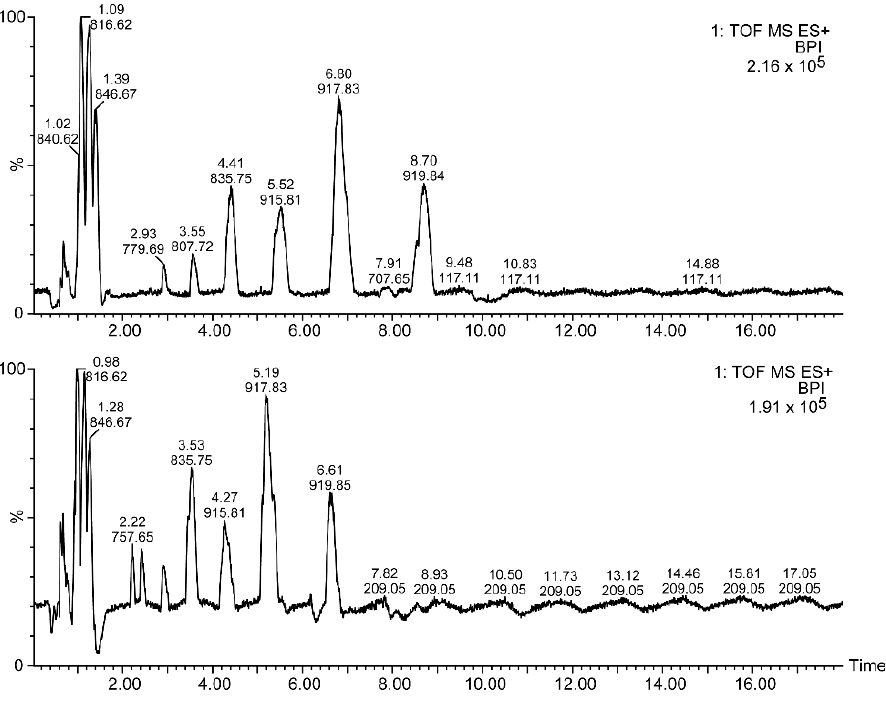
Figure 8. Base peak chromatograms of TAGs from ovine plasma at two NH 4 OH concentrations in the eluents: 54.78 mM ( upper panel) and 9.13 mM ( lower panel). The elution time and the m / z of the most intense peak is shown over each chromatographic